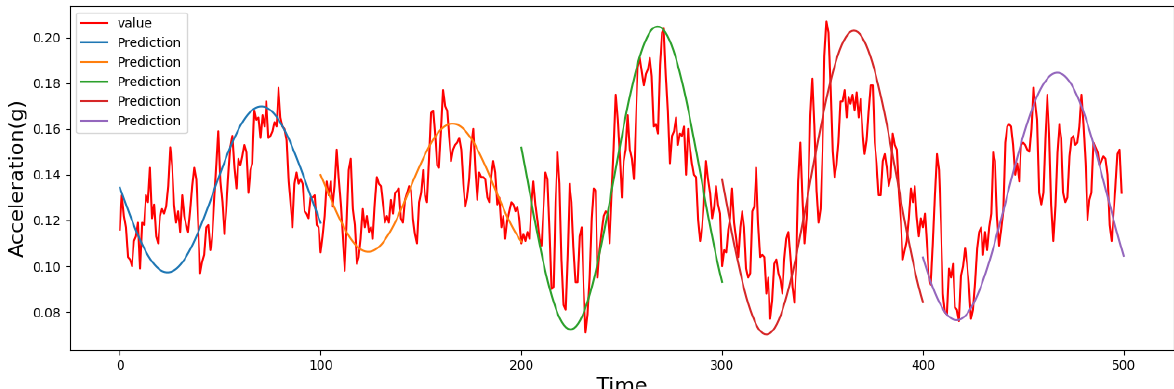
Figure 9. Structural state trend forecasting based on the FFT–Informer on the SMC data set. (Time represents the number of the predicted